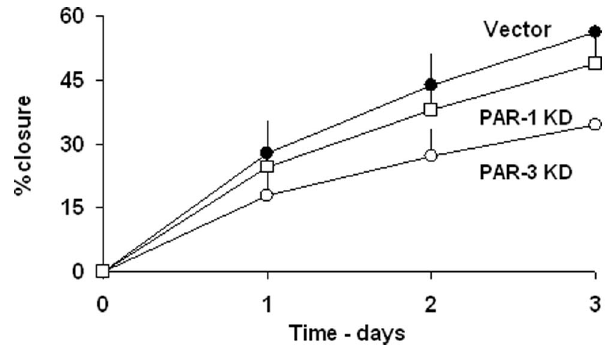
Figure 5. Cadherins’ mRNAs levels of vector-controls and PAR- 1 or -3 KD cells. Vector-control, PAR-1 or -3 KD cells were assayed for mRNA levels of the designated cadherins and normalized to GAPDH mRNA levels. The results are presented as fold difference of respective KDs mRNA levels to those of vector-controls. The results represent mean 6 SE, * denotes p ,